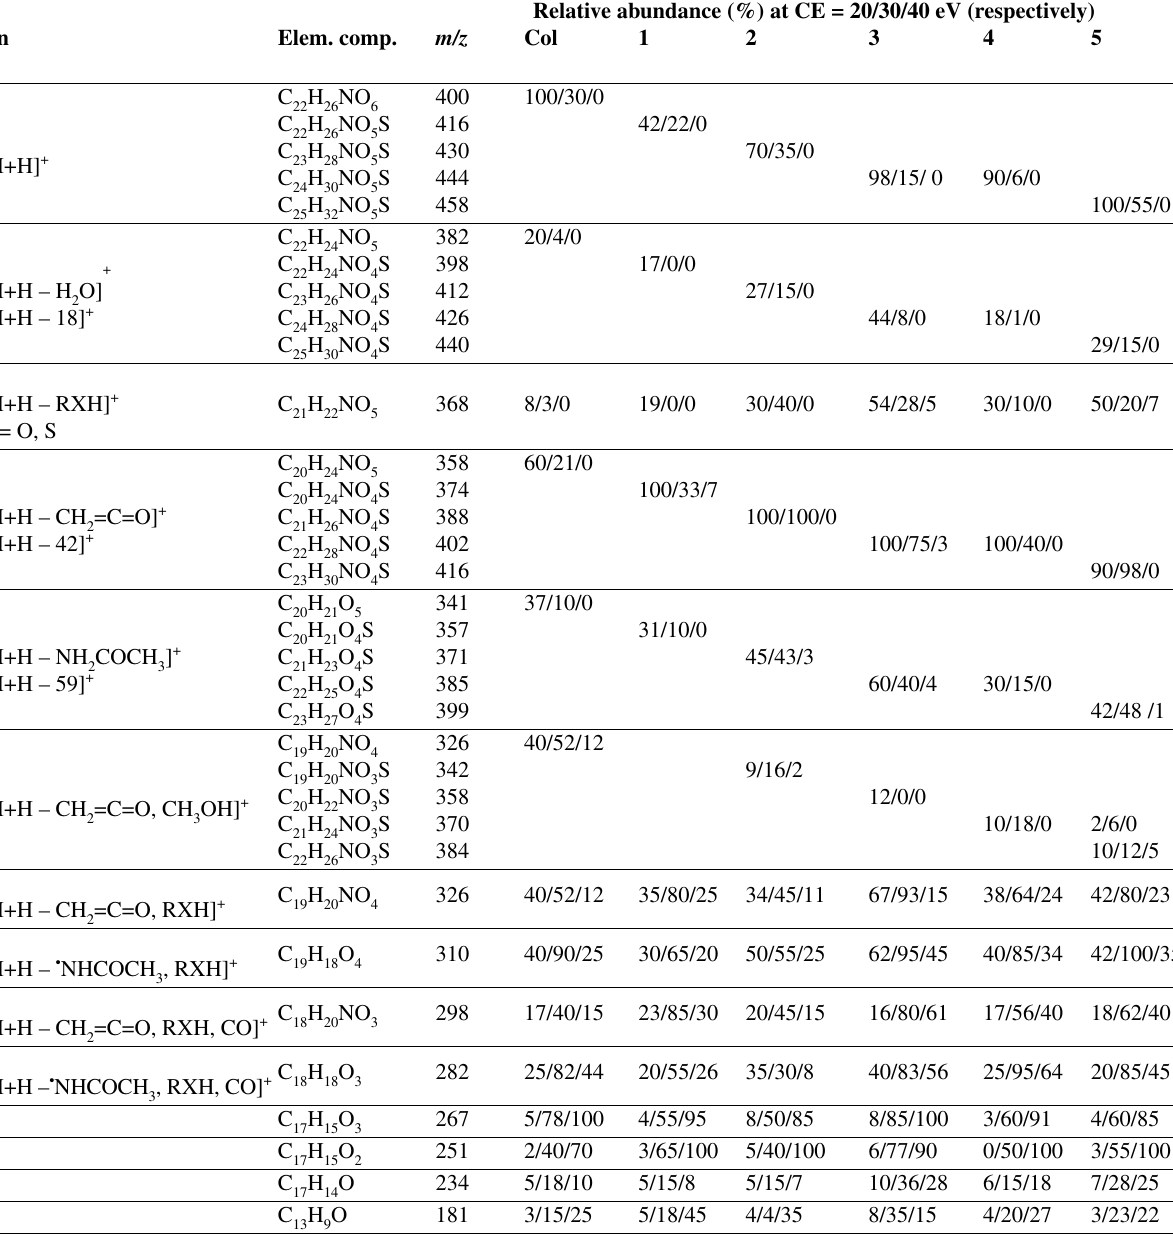
Table 4. Characteristic, the most abundant fragment ions derived from precursor ions [ M+H ] + in MALDI TOF MS/MS for compounds Col and 1 – 5 , matrix DIT; m/z values and relative abundances (%) at collision energies CE = 20, 30 and 40 eV. Relative abundance (%) at CE = 20/30/40 eV (respectively) Ion Elem.